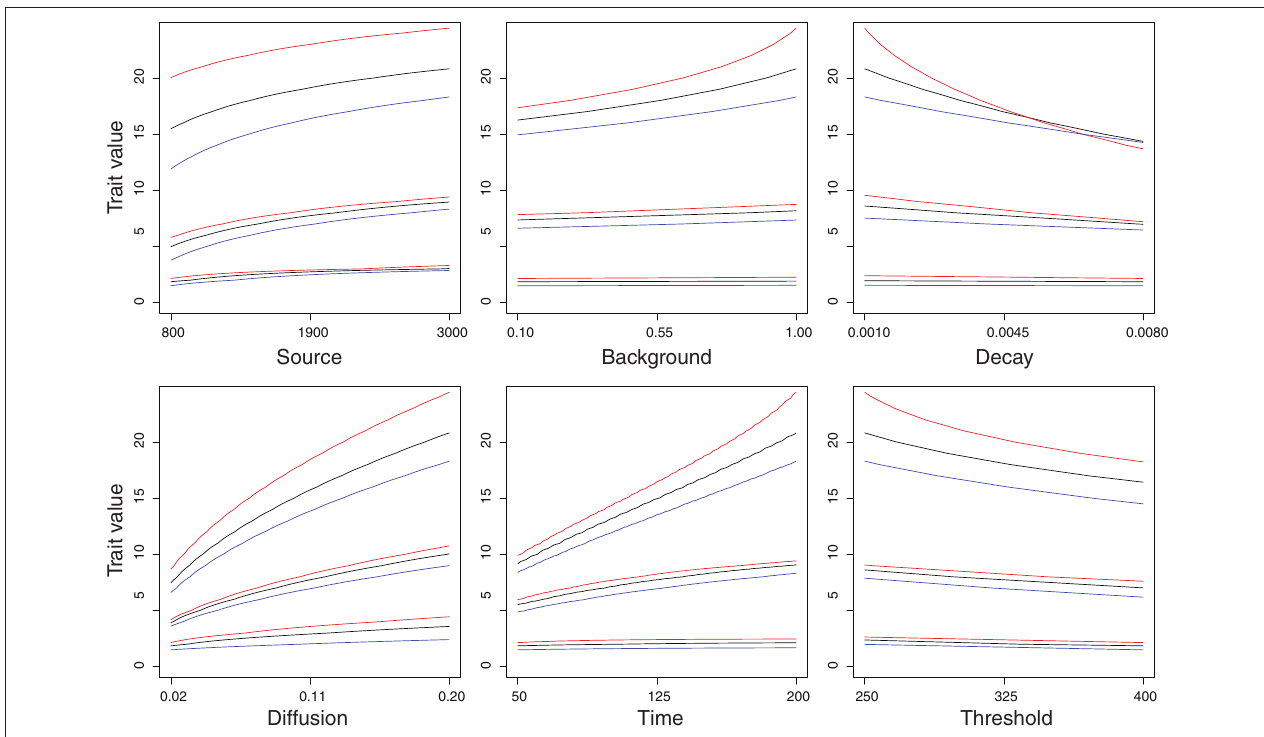
FIGURE 3 | Effects of temperature and genetic background on the functions relating values of the developmental parameters to the target phenotypes. In each panel, the trait values (with no stochastic variation, thus these are the target phenotypes) are plotted as a function of one of the parameters in the developmental model. Each panel contains three groups of curves, corresponding to the genotype for loci controlling the five remaining parameters in the developmental model: for the group at the top, all five loci have the LL genotype, for the middle group, they have the SL genotype, and for the bottom group, they have the SS genotype. In each group, the black curve is the function at the reference temperature, the red curve is the function at the warm temperature (reference + 5 ◦ ) and the blue curve is the function at the cold temperature (reference − 5 ◦